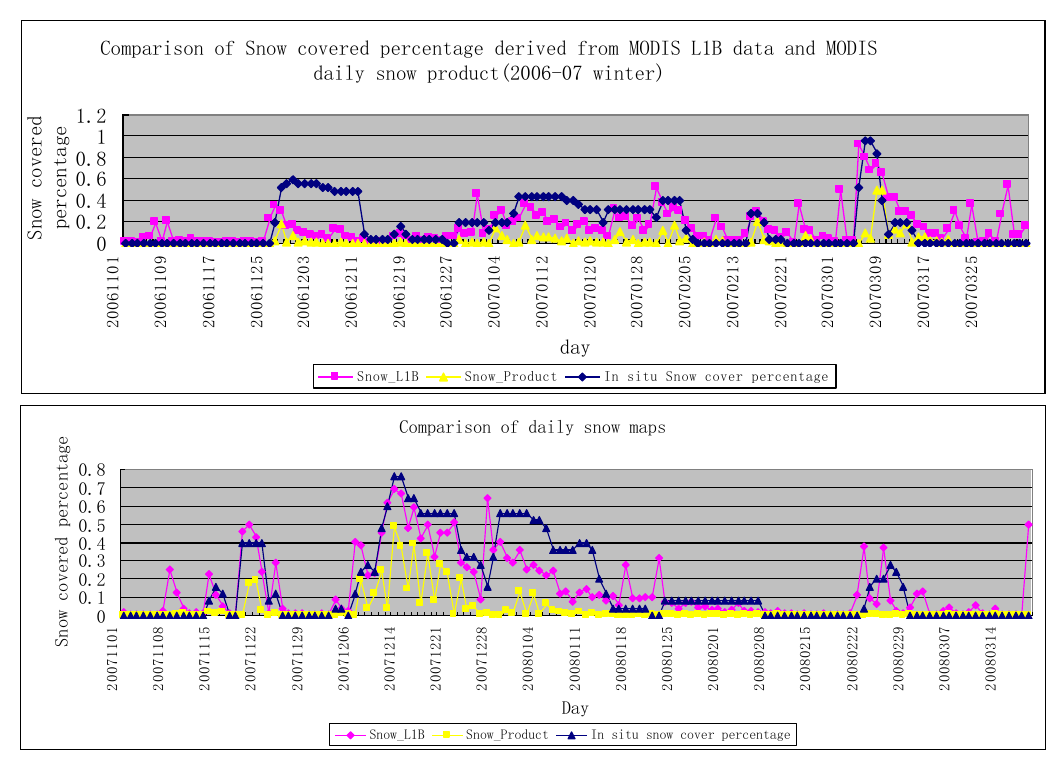
Figure 9. Comparison of snow covered percentage derived from in situ measurement, the study model, and MODIS Daily Snow